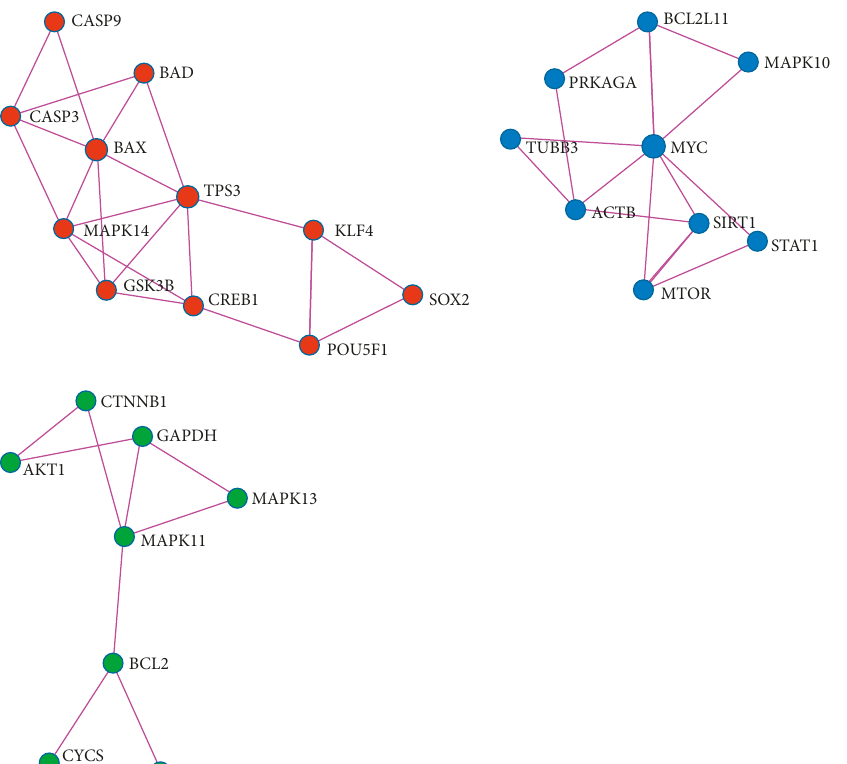
Figure 7: MCODE protein-protein interaction network. Colors show the different components of MCODE (red color: MCODE 1, blue color: MCODE2, and green color: MCODE